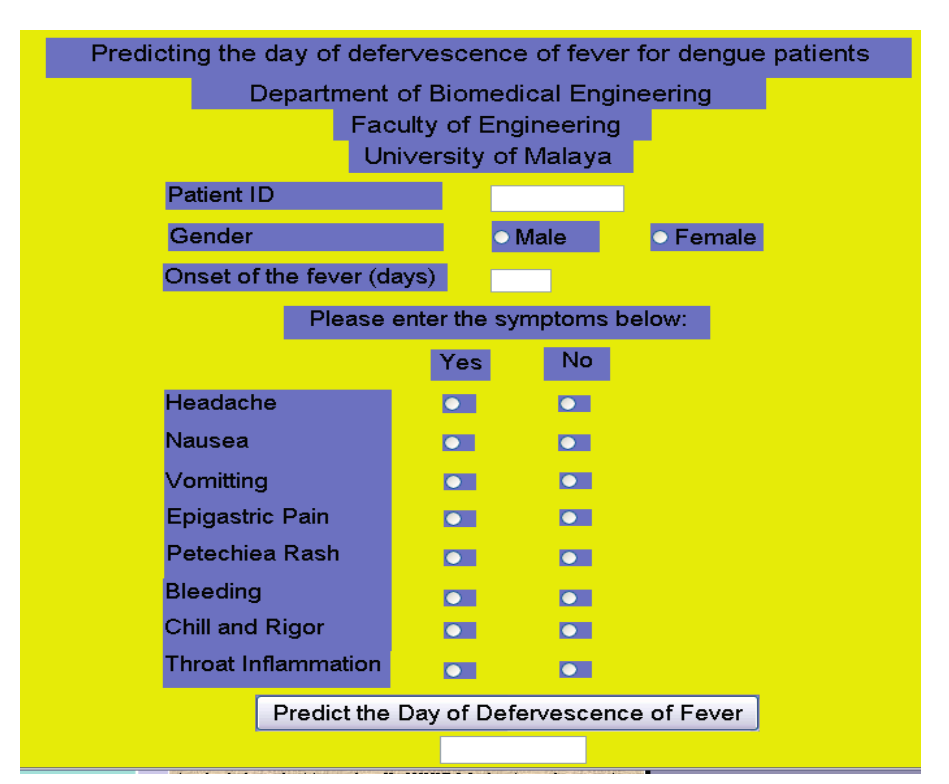
Figure 3. Graphic interface screen for the prediction of day of defervescene of fever in dengue